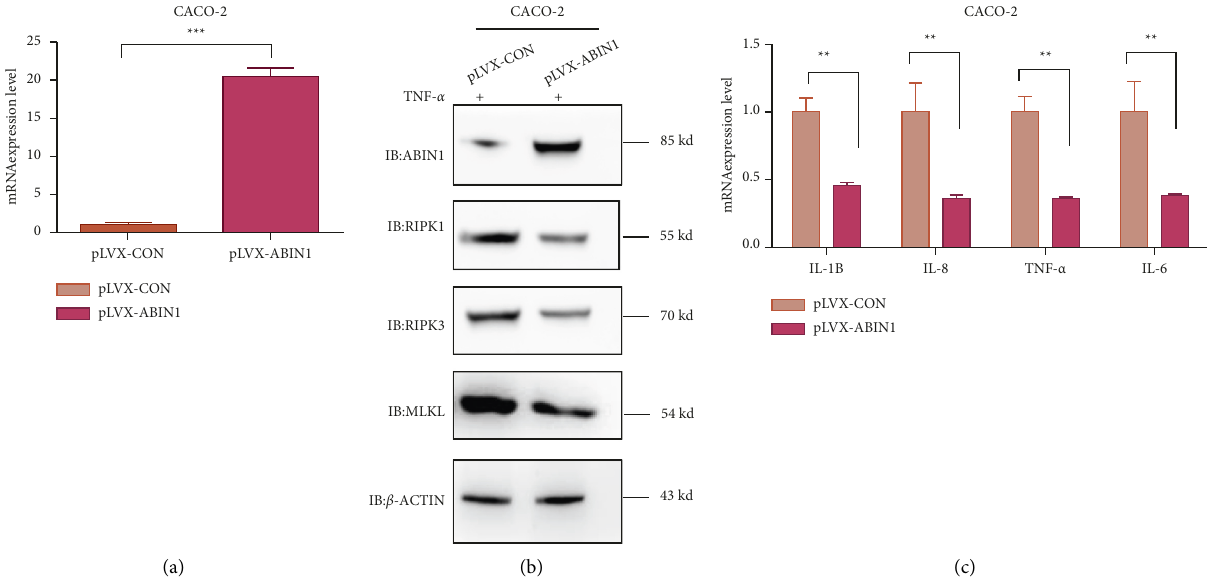
Figure 2: ABIN1 overexpression in IEC inhibits necroptosis and the expression of proinflammatory cytokines in IEC: (a) mRNA expression level overexpression verification in CACO-2 cells; (b) Necroptosis-associated proteins detection in CACO-2 ABIN1 overexpression stable upon TNF- α stimulation; and (c) mRNA expression level of proinflammatory cytokines in ABIN1 overexpression CACO-2 cells. Two-tailed Student’s t -test was performed to assess statistical significance. ∗∗ P < 0 . 01, ∗∗∗ P < 0 .